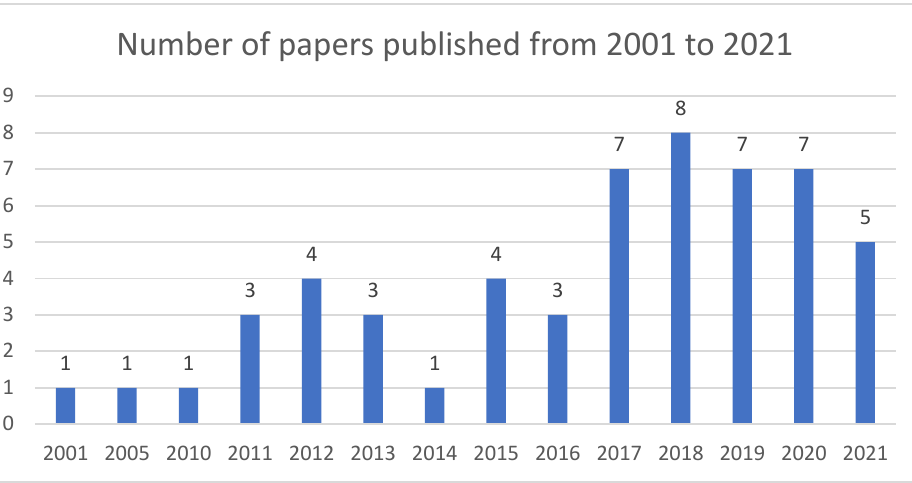
Figure 3. Distribution of the articles reviewed in the study by year.